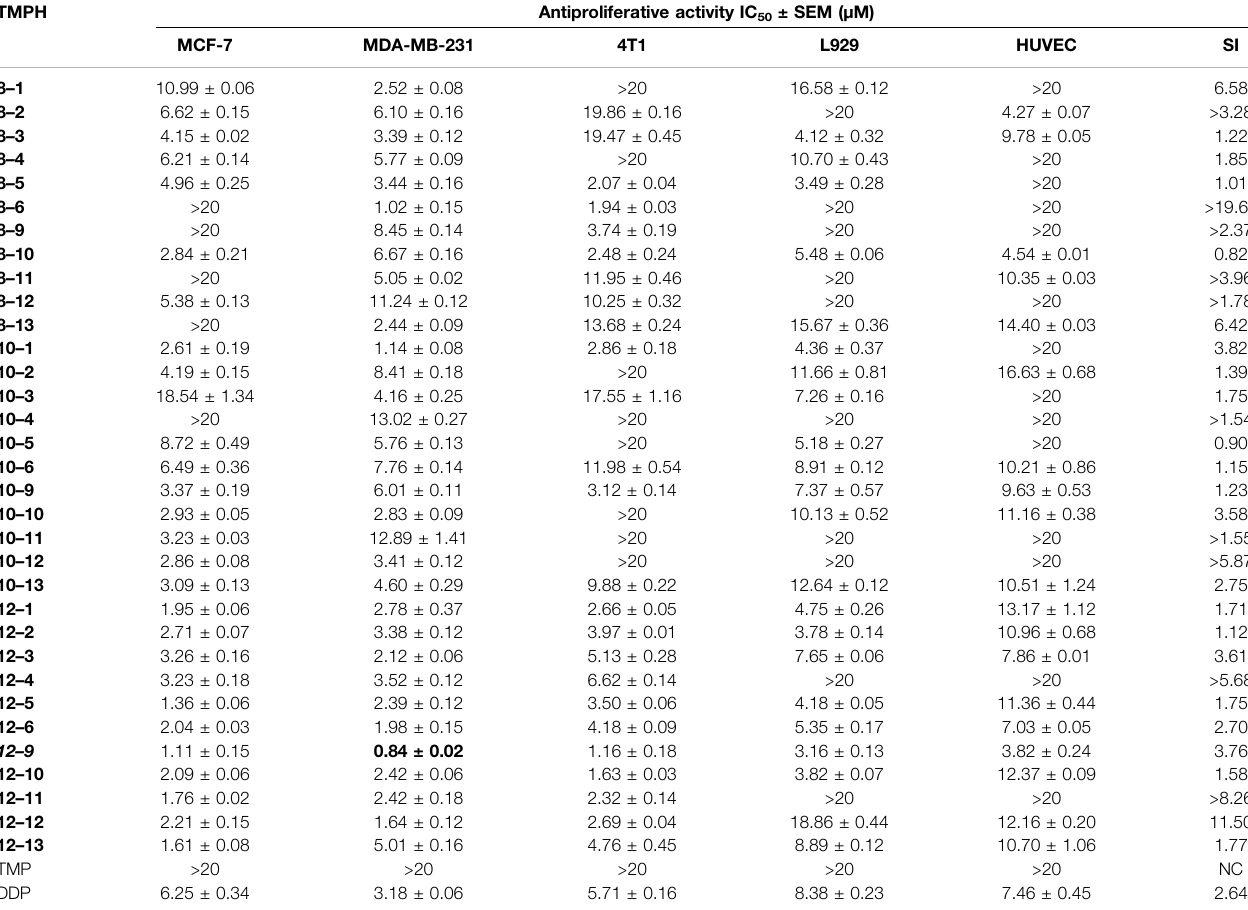
TABLE 1 | Cytotoxicity of ligustrazine – heterocyclic derivatives (TMPH) to fi ve kinds of cells by MTT